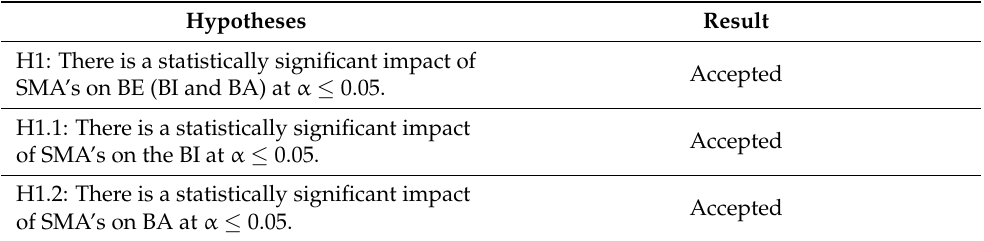
Table 13. Research Hypotheses